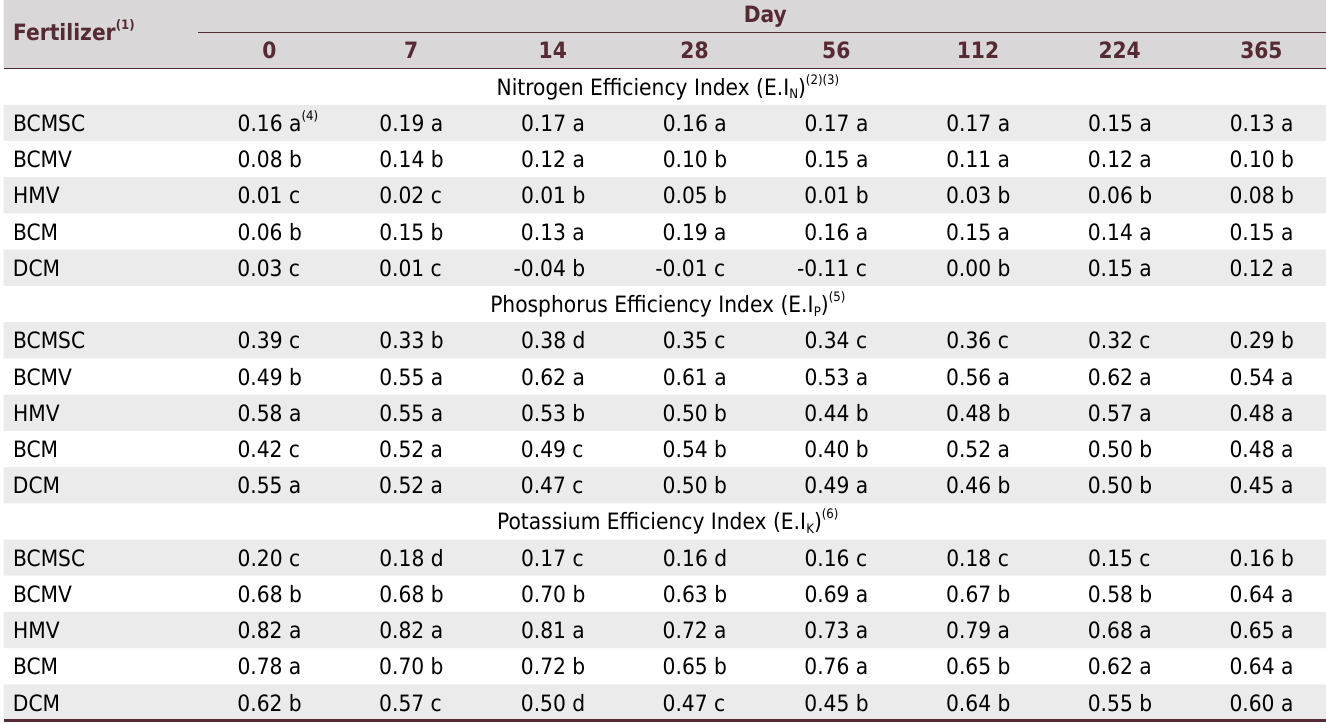
Table 2. Organic fertilizer efficiency index of beef cattle manure/straw compost (BCMSC), beef cattle manure vermicompost (BCMV), high moisture vermicompost (HMV), beef cattle manure (BCM), and dairy cattle manure (DCM) Fertilizer